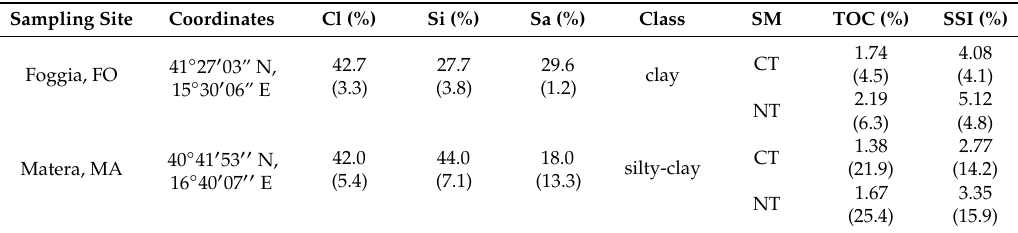
Table 1. Geographical coordinates of the sampled sites, mean and coe ffi cient of variation values (between brackets) of clay (Cl), silt (Si), sand (Sa), soil total organic carbon content (TOC) and structure stability index (SSI). The USDA classification (class) of soil texture and the soil management (SM) were also reported. Note that reported data refer to the soil 0–20